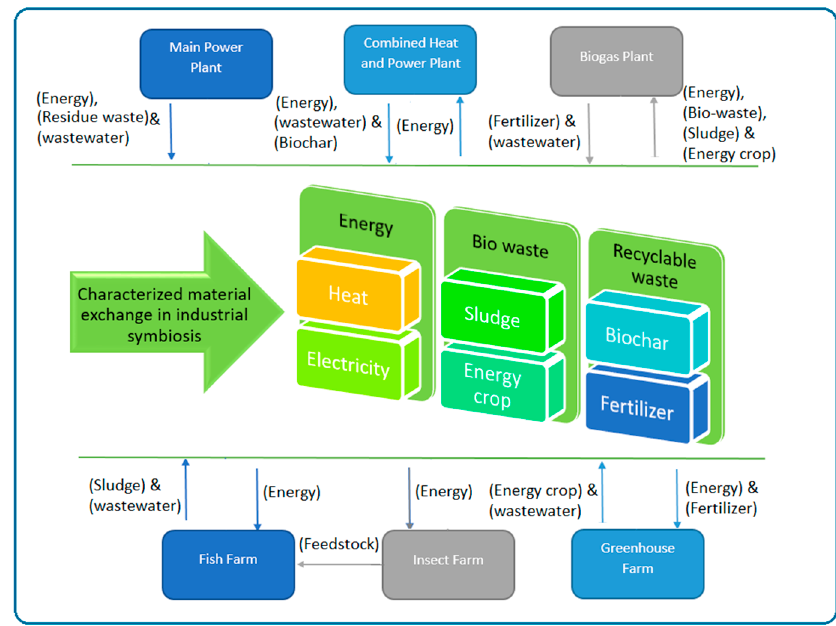
Figure 4. Identifying material exchange in IS network. Table 3. Life cycle cost parameters of products.